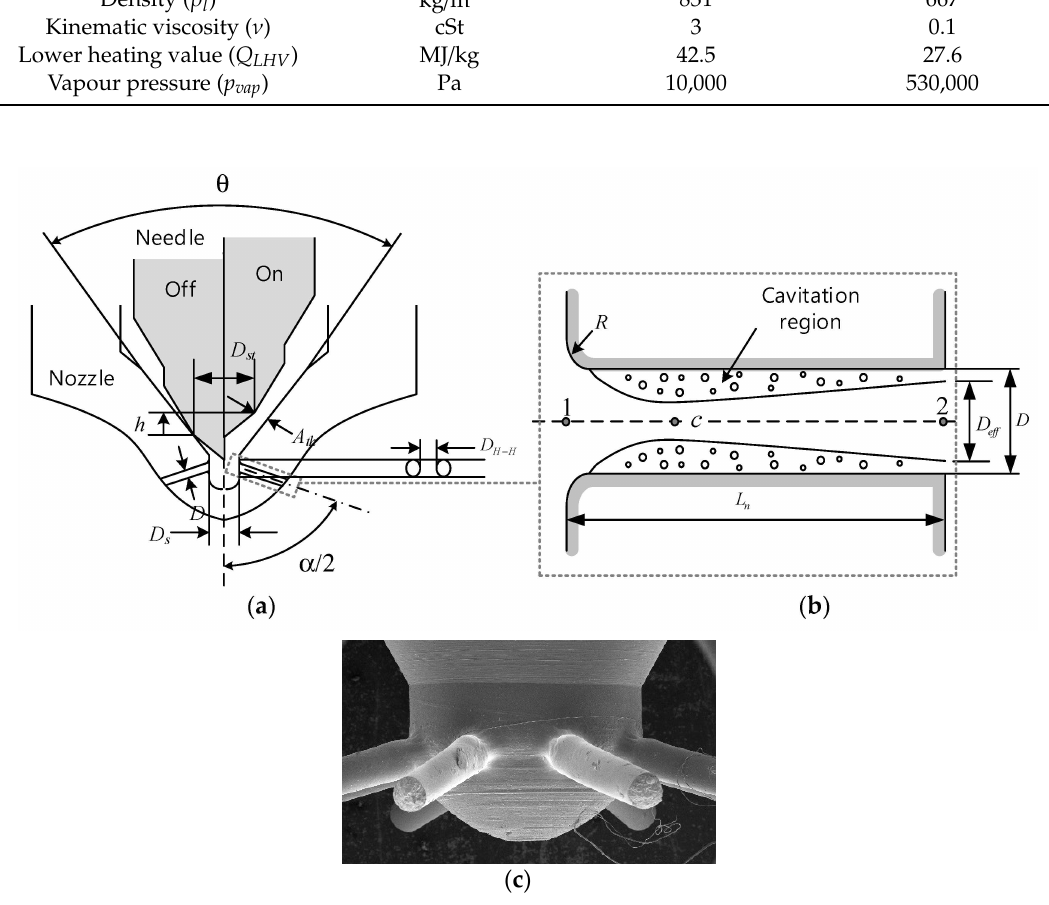
( c ) Schematic diagram and SEM image of the injector nozzle. Figure 1. Figure 1. Schematic diagram and SEM image of the injector nozzle. ( a ) Nozzle with needle; ( b ) Nozzle flow model [11,12]; ( c ) Scanning Electron Microscope (SEM) image of the nozzle Table 1. Specifications of the base injector nozzle.